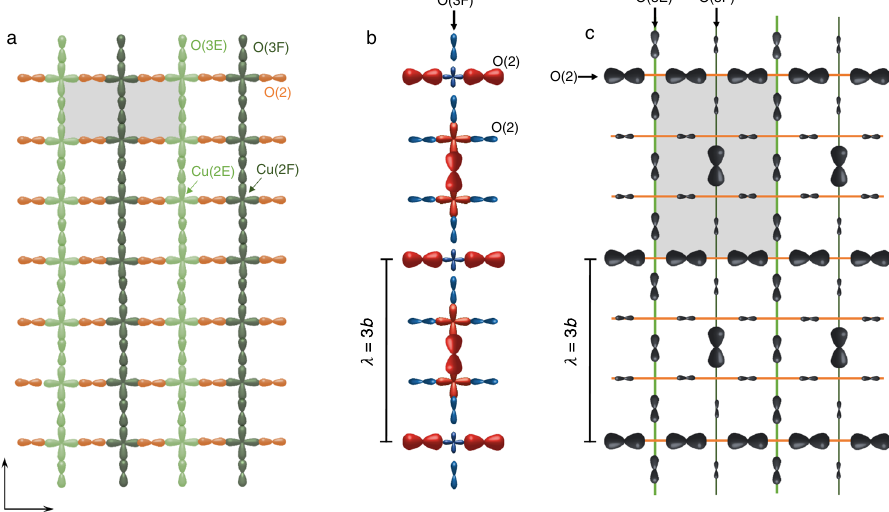
Fig. 2 Crystallographic sites and possible CDW pattern in CuO 2 planes of ortho-II YBCO. a Crystallographic structure with inequivalent sites in CuO 2 planes with alternating rows of Cu(2E) and O(3E) below empty chains (light green) and rows of Cu(2F) and O(3F) below oxygen-full chains (dark green). The grey rectangle shows the crystallographic unit-cell in the O-II structure. b Charge distribution pattern below full chains compatible with O(2) and Cu NMR line shapes. The size of the orbitals approximately scales with the charge density while the red (blue) colours represent positive (negative) variations with respect to the average density (same red/blue colour code as in Figs. 1, 3). The charge pattern at Cu sites has a phase shift δϕ = π with respect to O(2) sites, consistent with our analysis of the line shapes in Fig. 3 (see text). The modulation at O(3F) is chosen to be in-phase with Cu(2F), implying a d form factor ( δϕ = π ) between O(3F) and O(2) (see discussion in text). c Larger fi eld of view of the charge density pattern in a CuO 2 plane, showing only the O sites (Cu sites are omitted). The grey rectangle shows the electronic unit cell. The depicted pattern is a simpli fi ed version of the actual modulation in two respects: (1) the modulation is depicted with the same amplitude for O(3F) and O(2) sites while the amplitude is likely to be different (presumably smaller at O(3) sites by a factor up to 3, see Supplementary Note 4). (2) The modulation amplitude at O(3E) and Cu(2E) sites, i.e. below empty chains, is set to zero but it may only be smaller than below full chains (by a factor of at least 3) as both possibilities are compatible with the absence of visible splitting of the Cu(2E)